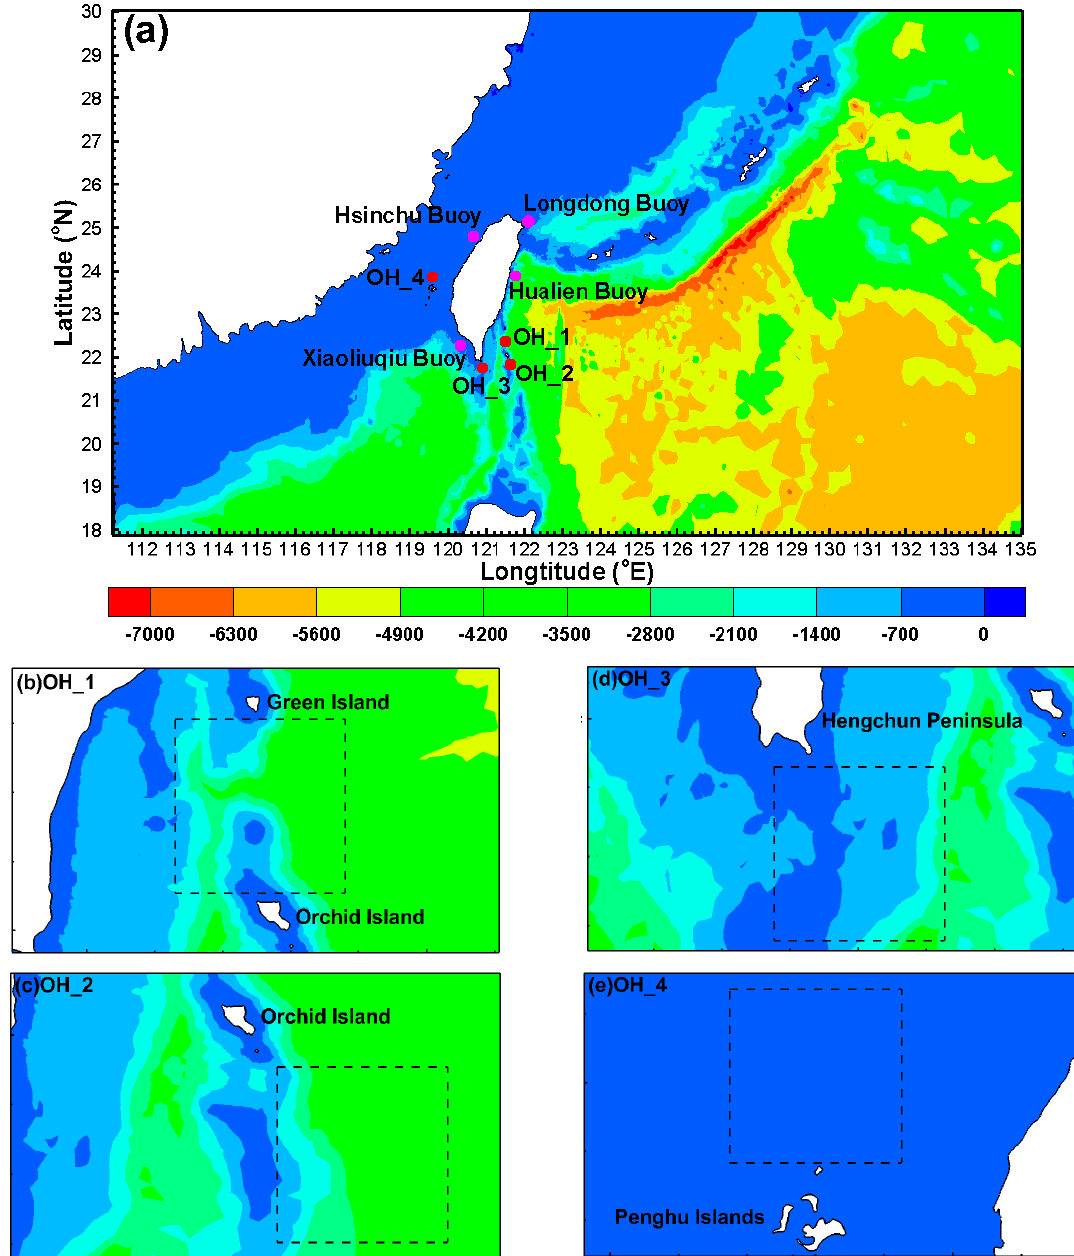
Figure 3. ( a ) Bathymetry for the whole computational domain and ( b ) magnified views of the bathymetry for offshore hotspot OH_1, ( c ) OH_2, ( d ) OH_3 and ( e ) OH_4.